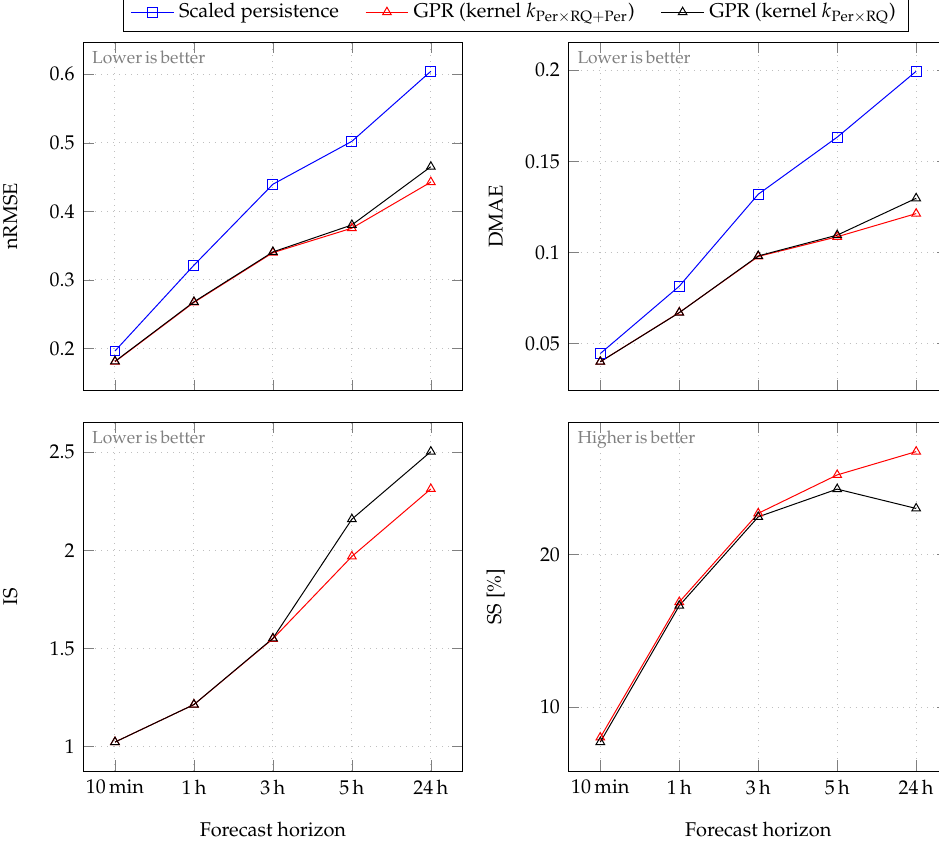
Figure 10. Performance criteria values for time-based GPR models. Values are calculated considering test data (year